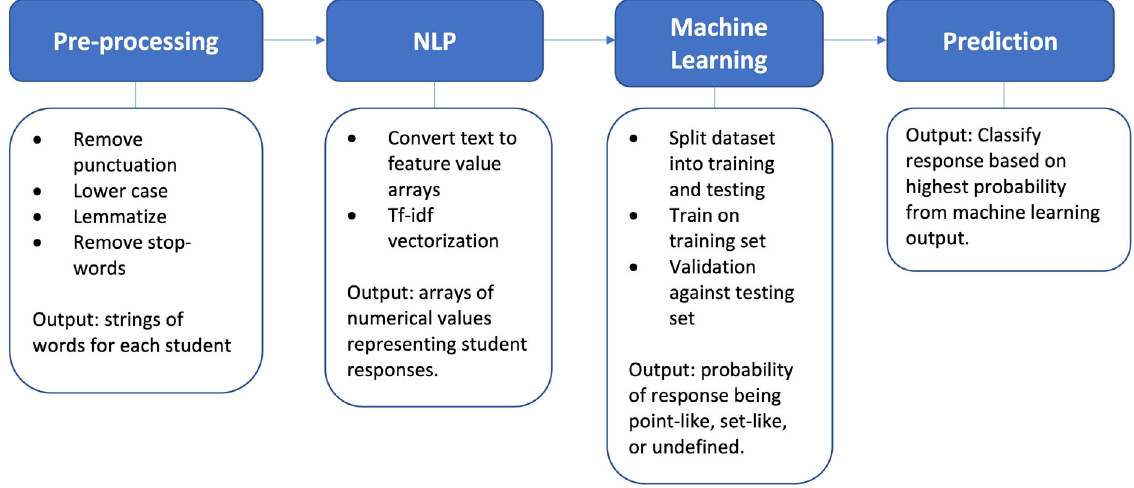
FIG. 3. A diagram of the process of analyzing student responses to the PMQ. The raw responses are preprocessed and then vectorized using NLP. These feature vectors are the input to the machine learning algorithm. The algorithm outputs probabilities that are used to predict in which category a response